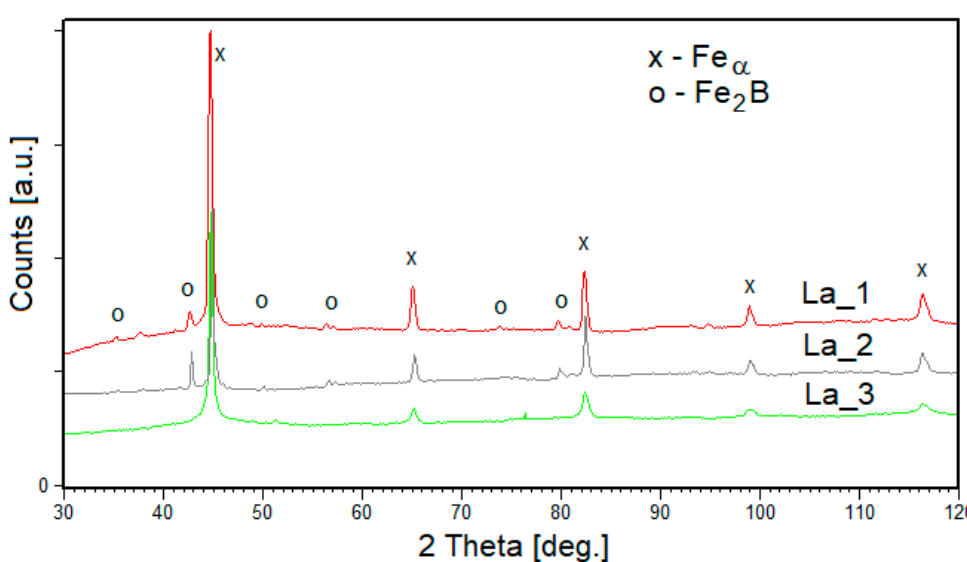
Figure 3. The X-ray diffraction patterns obtained for tapes of Fe-B-La-Al alloys marked with the La_1, La_2, and La_3, respectively. Table 6. Crystallite size and changes of unit cell parameters of the main phases present in tested Fe-B-La-Al alloy tapes. Table 5. Quantitative phase analyses of the main phases present in tested Fe-B-La-Al alloy tapes (wt.%).